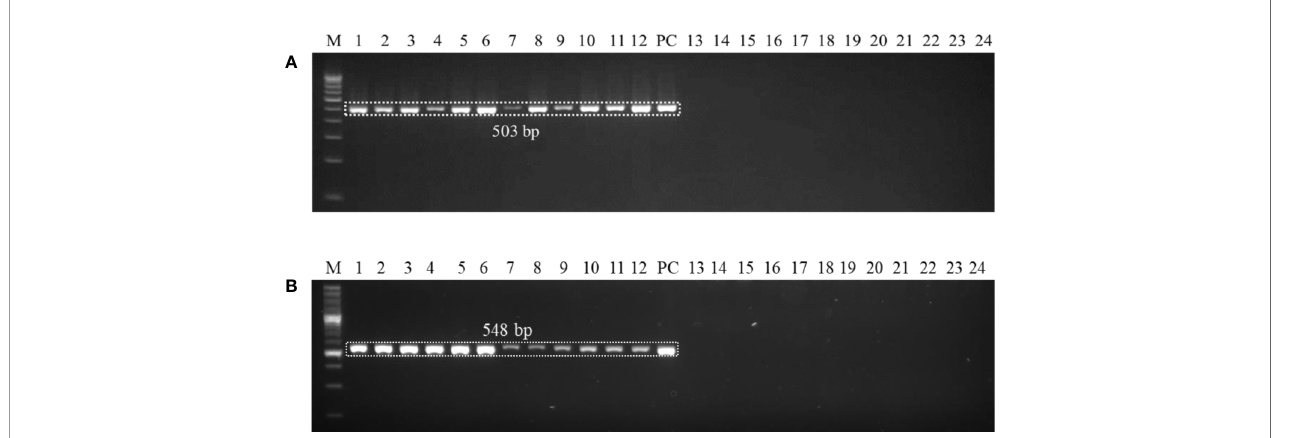
FIGURE 3 | Polymerase chain reaction (PCR) mediated detection of U. agropyri in wheat tissues of six wheat cultivars ( viz ., PBW343, PBW550, HS673, WH1105, DBW107, and HI1563) using UA-17F/UA-519R (A) and UA-15F/UA-562R (B) primer sets. Lanes 1 – 12: Wheat tissue ( viz ., PBW343, PBW550, HS673, WH1105, DBW107, and HI1563) sampled from U. agropyri disease sick plot at 20 DAS (Lanes 1 – 6) and 40 DAS (7 – 12); Lanes 14 – 24: Negative control and include wheat tissue ( viz ., PBW343, PBW550, HS673, WH1105, DBW107, and HI1563) sampled from sterilized healthy soil free U. agropyri spores at 20 DAS (Lanes 13 – 18) and